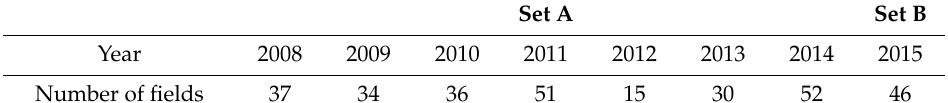
Table 1. The number of arable fields of winter wheat divided into two sets, A and B.